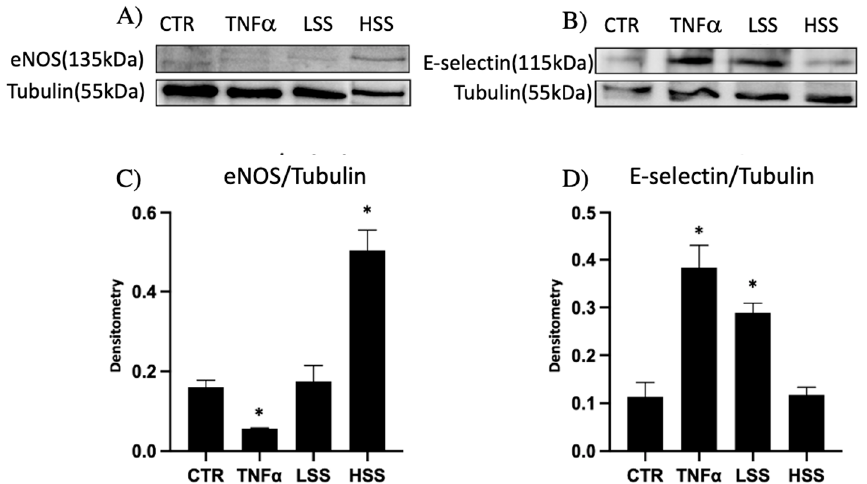
Figure 3. Western blot analysis of eNOS ( A ) and E-selectin ( B ) in HUVECs cultured under shear stress. ( C , D ) represent the normalization data of eNOS and E-selectin, respectively (* p < 0.05 vs. control).